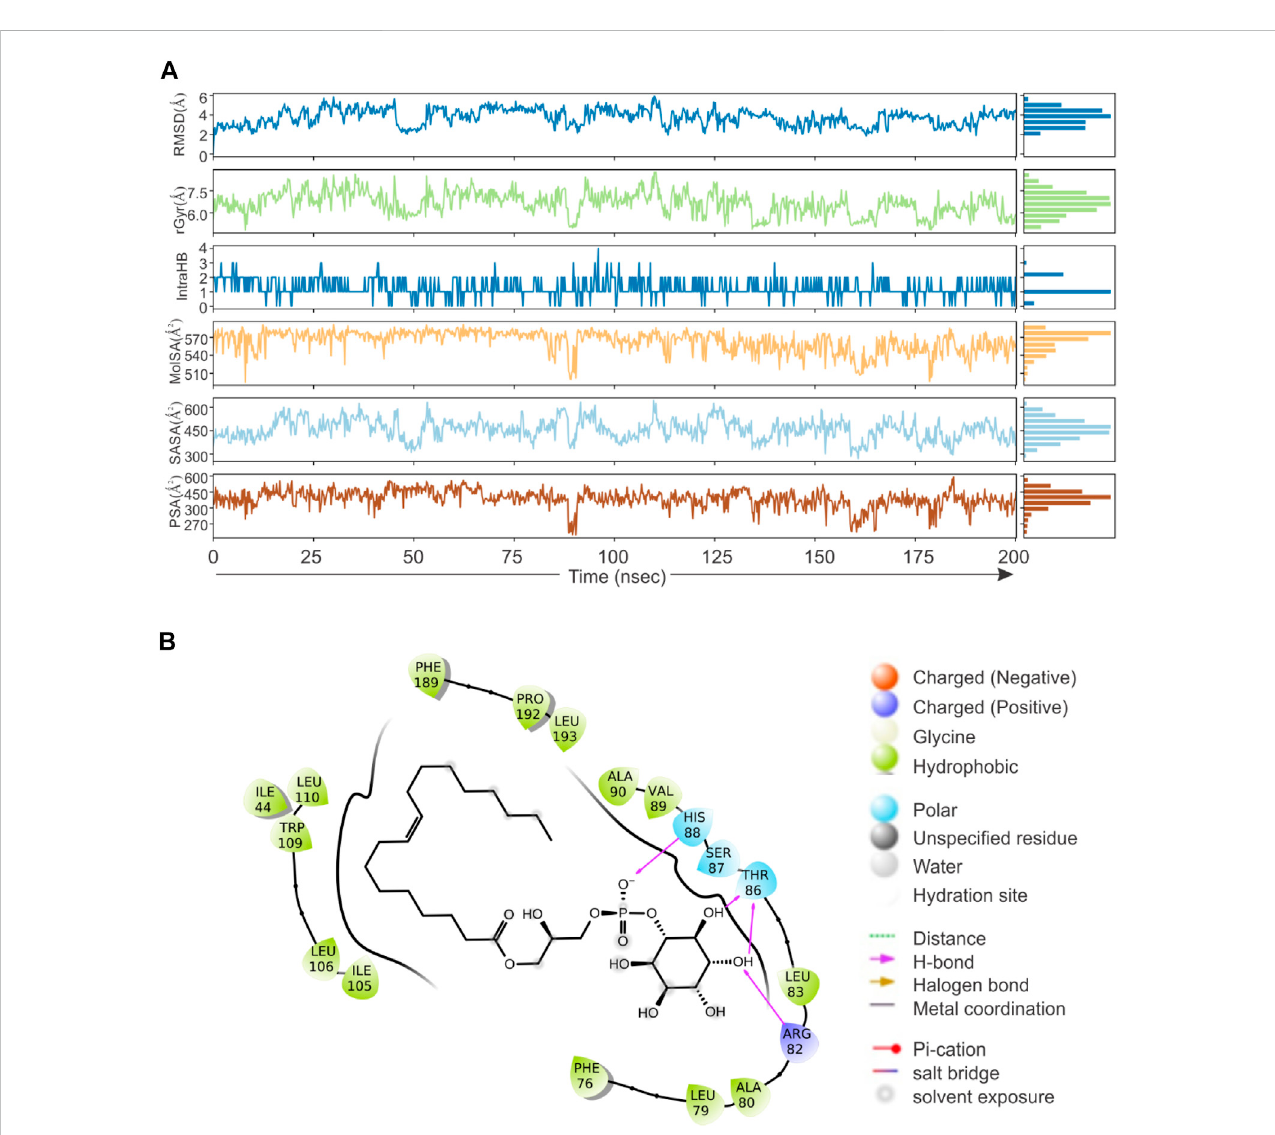
FIGURE 3 Virtual screening, docking and ligand property. A library of 307,814 compounds (a total 481,799 structure) has been used as a screen library. (A) RMSD, radius of gyration, MolSA, SASA and PSA characteristics of 1-oleoyl-2-hydroxy-sn-glycero-3-phospho-(1 ′ -myo-inositol). (B) The molecular Interaction of 1- oleoyl-2-hydroxy-sn-glycero-3-phospho-(1 ′ -myo-inositol) within active site of KSHV-encoded protease ORF17. Charged (positive/negative), glycine, hydrophobic,polar, water hydration sites, hydrogen bond, halogen bond, metal co-ordinates, Pi-cation, saltbridge and solvent exposure characteristics are